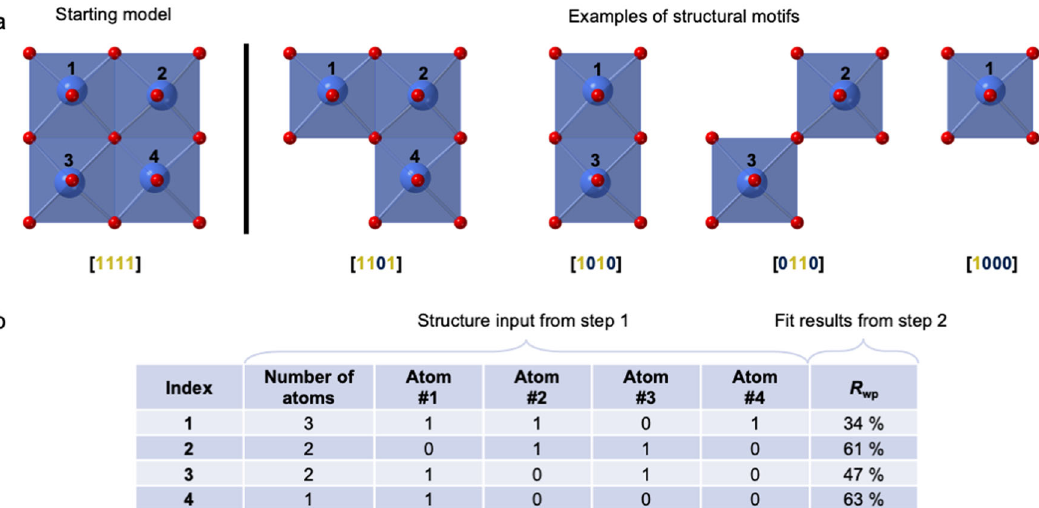
Fig. 10 Example of how structure motifs can be extracted from a starting model with 4 metal atoms coordinated to oxygen and used as input to the GBDT model. a The metal atoms are permuted randomly by creating an array of zeros and ones, where 0 refers to a deleted atom and 1 refers to an atom that is kept in the structure. Oxygen atoms are removed if they do not bond to any metal atoms within a distance threshold that is set by the user. Note that the metal atoms (blue) are slightly distorted from the centre of the octahedra. b Example of how the four structures from panel a and Fig. 1 are given as input to the GBDT model which predicts the R wp